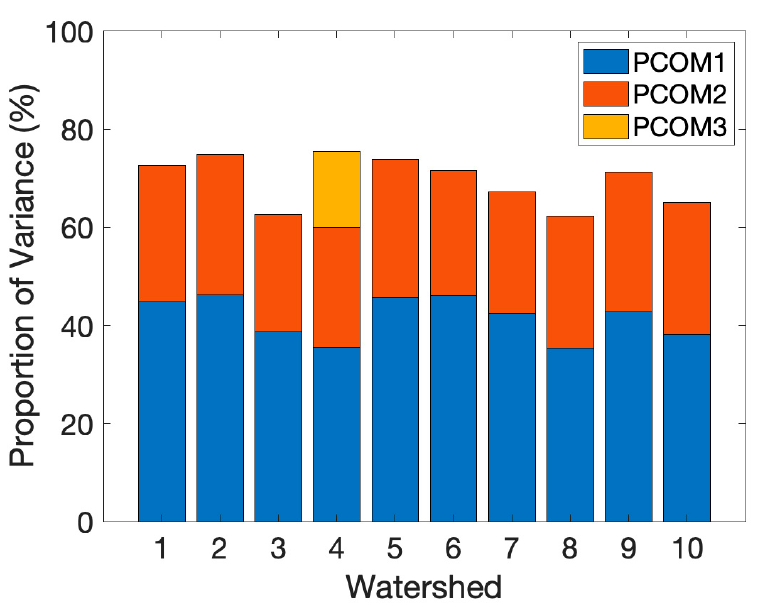
Figure 6. Proportion of variance explained by each principal component for the 10 watersheds.